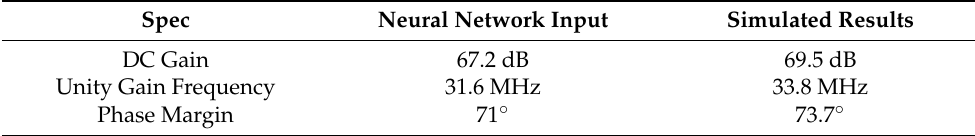
Table 6. Simulated results of the designed circuit compared to the required